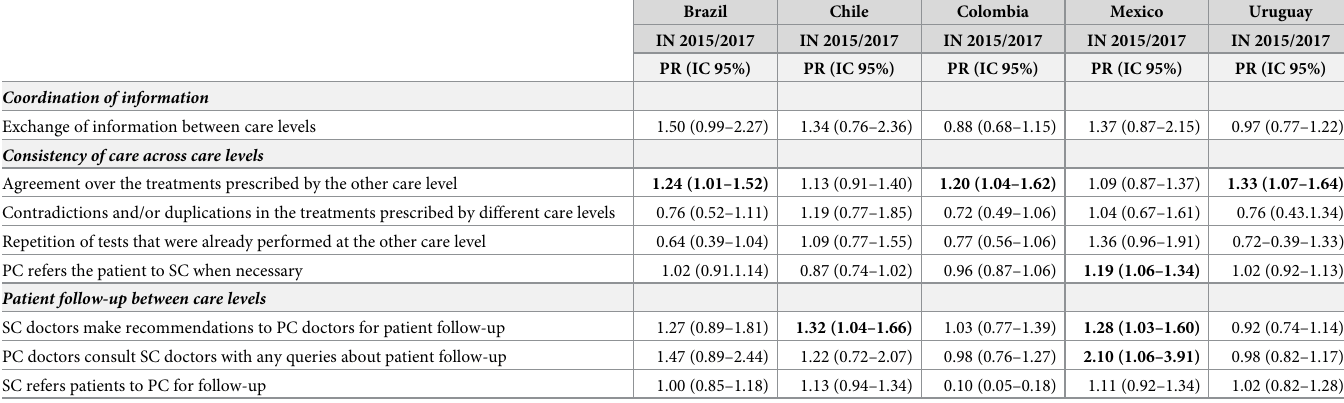
Table 5. Changes in the experience of cross-level coordination of information and clinical management of care (distal outcomes) between 2015 and 2017 in the intervention networks of each